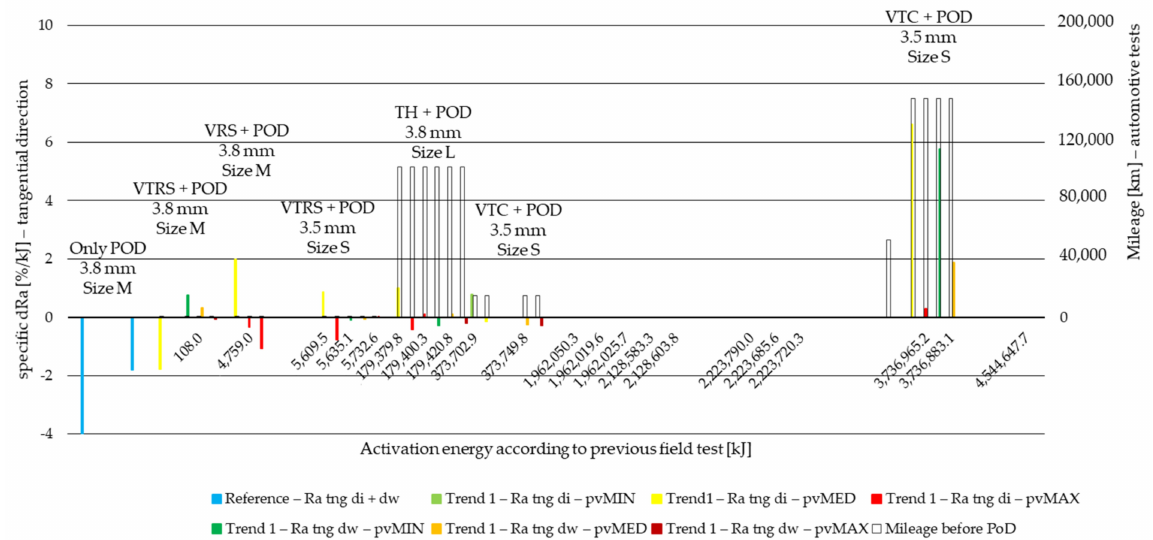
Figure 16. Tangential direction PoD specific Ra difference values of cut material samples from inner and working diameter after minimum, medium and maximum pv level pin-on-disc tests with previous field-test (Table 2) mileage along Joule scale—Trend 1: clutch killer load cases: VTRS, VRS, TH, VTC.